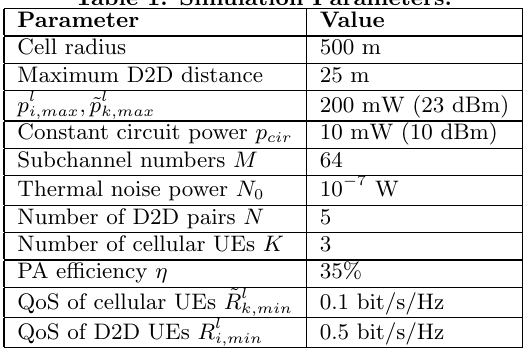
the nonlinear fractional programming for D2D UEs and cel- lular UEs. We derived an iterative algorithm for solving the non-convex problem, which was shown to converge to the optimum value very fast. Simulation results have demon- strated that the proposed EE algorithm can bring signifi- cant EE improvement. Compared to the spectral-efficient algorithm, the proposed algorithm improves the EE perfor- mance by 94 . 29% and 90 . 3% for D2D UEs and cellular UEs